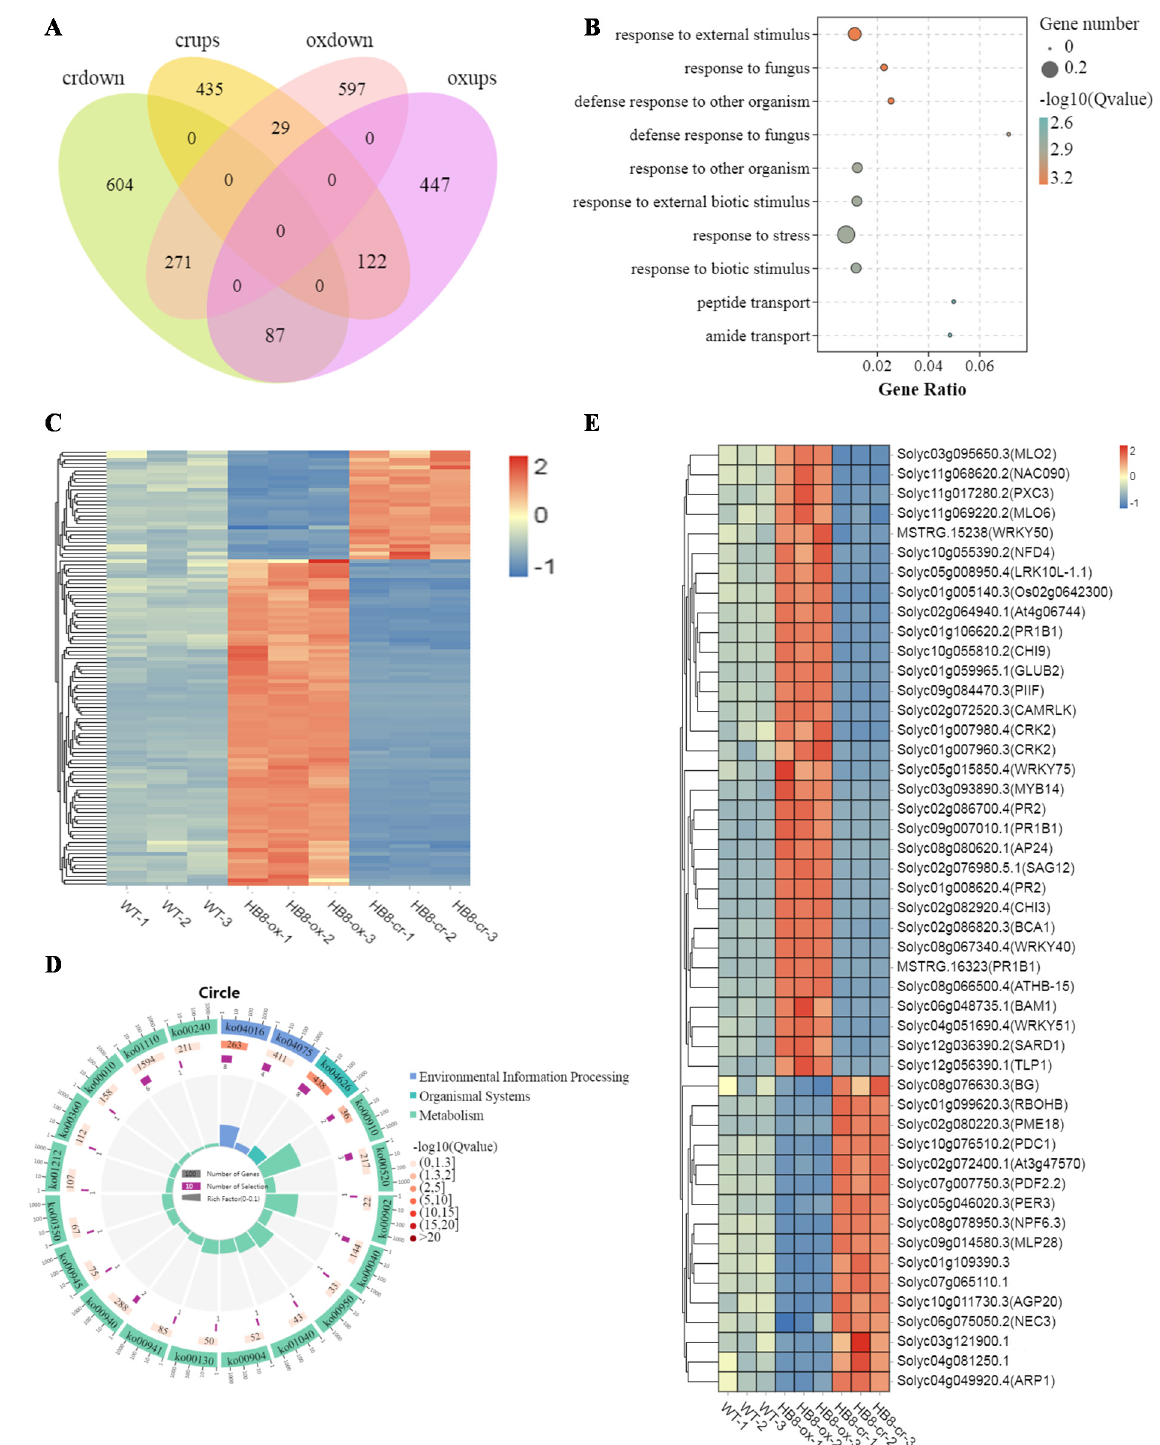
Figure 5. Prediction and functional analysis of DEGs directly regulated by SlHB8. ( A ) Venn diagrams selecting 116 DEGs with reversible expression pattern potentially directly regulated by SlHB8. ( C ) Heat maps of predicted 116 DEGs directly regulated by SlHB8. ( B ) Significantly enriched GO terms based on the 116 DEGs; ( D ) Significantly enriched KEGG terms based on the 116 DEGs; ( E ) Heatmap of DEGs related to disease resistance.